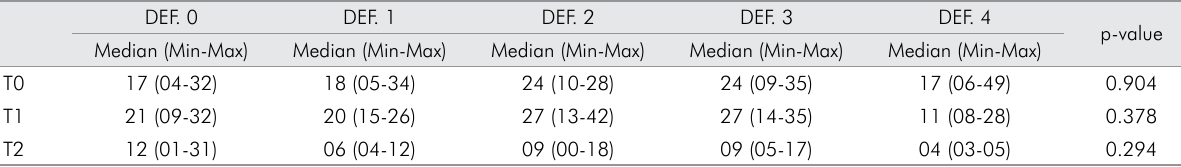
Table 3. Comparison of the OHIP-14 values in the three times of the patients with dentofacial deformities (case group). DEF.